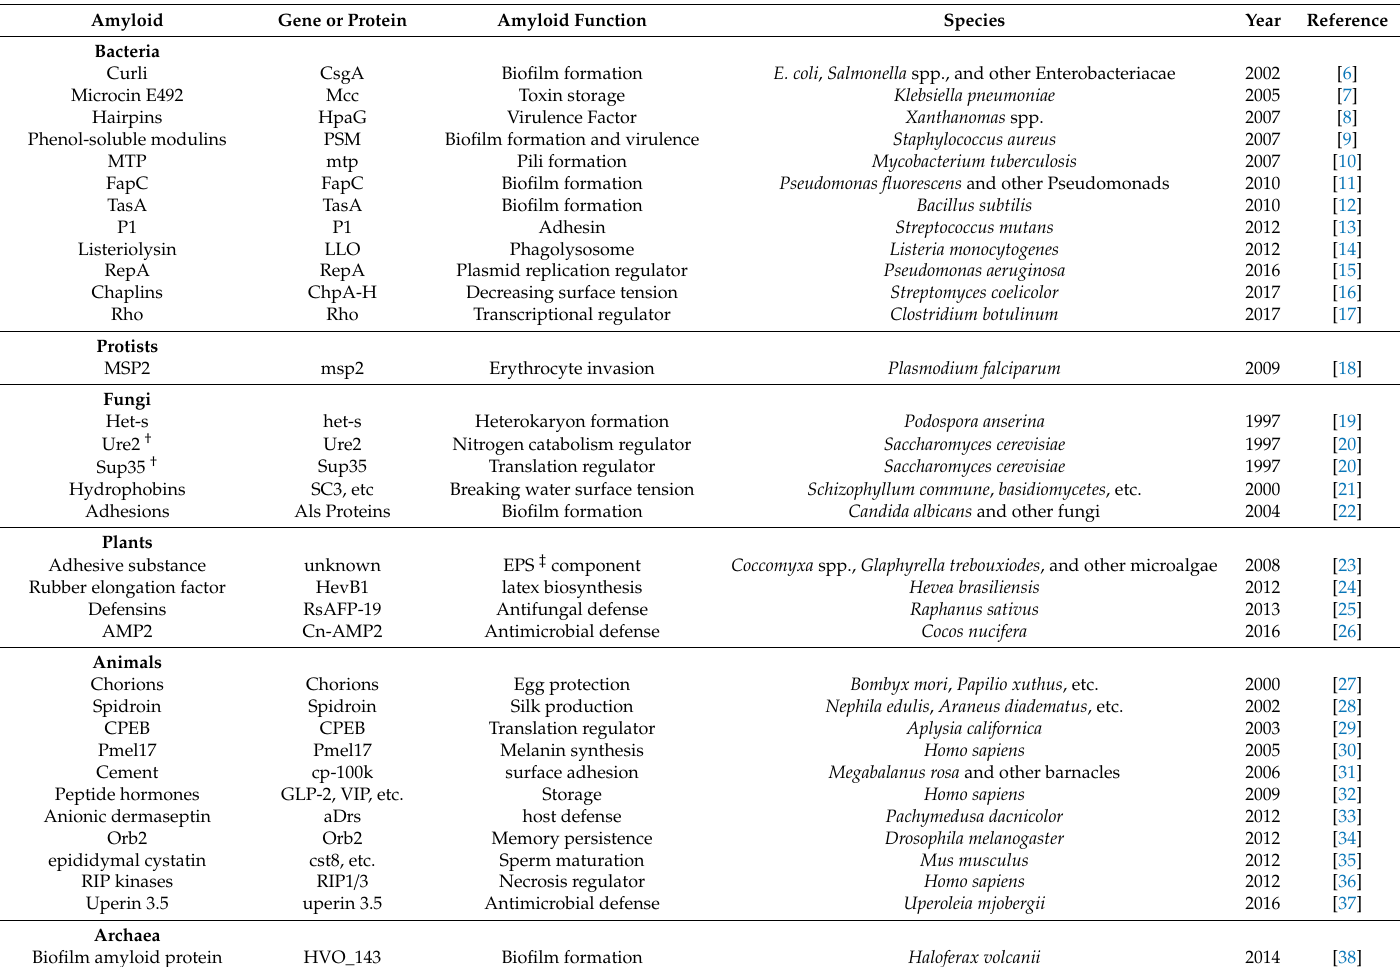
Table 1. Known functional amyloids and their wide range of putative